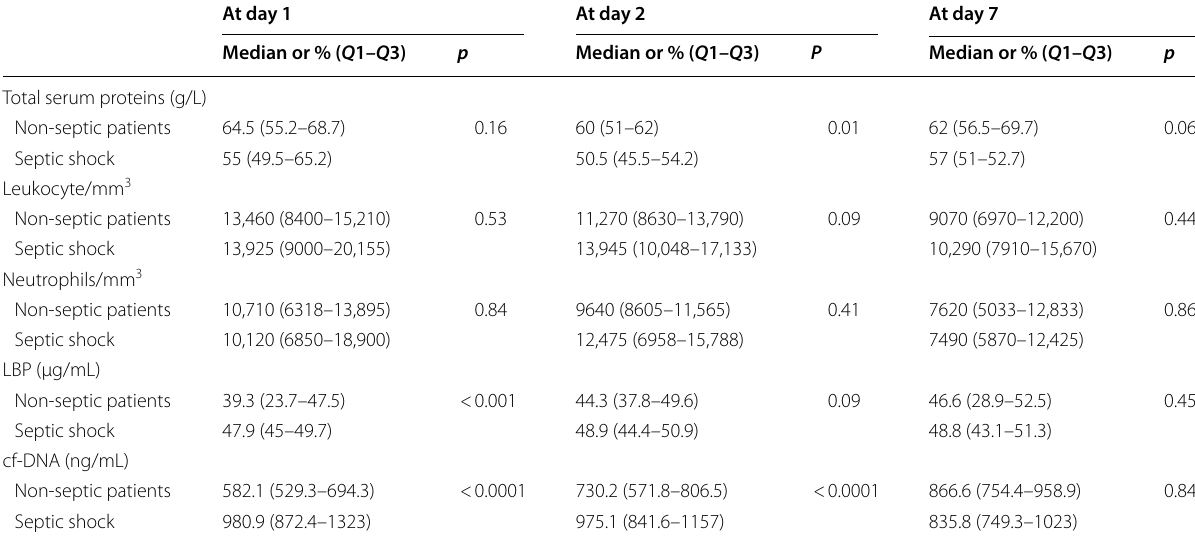
Continuous variables are expressed as medians (interquartile range), and categorical variables are expressed as frequencies